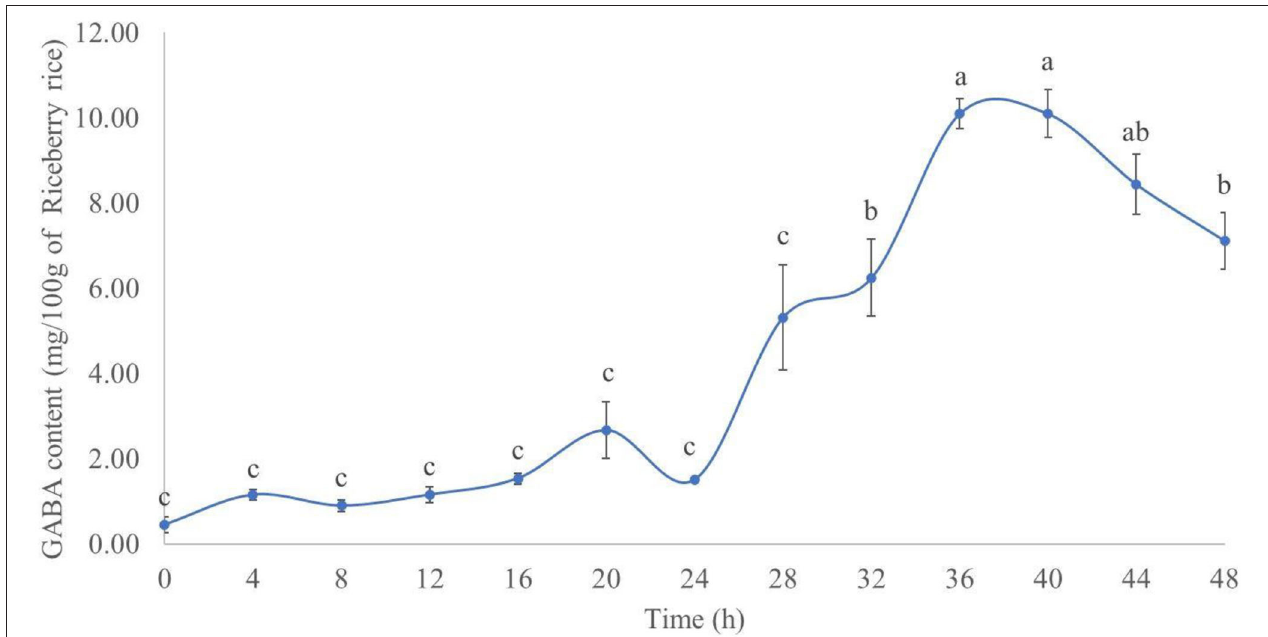
FIGURE 1 | GABA content (mg/100g of dry Riceberry rice) in germinated rice between 0 and 48h. Results with the same superscript were not significantly different ( p >